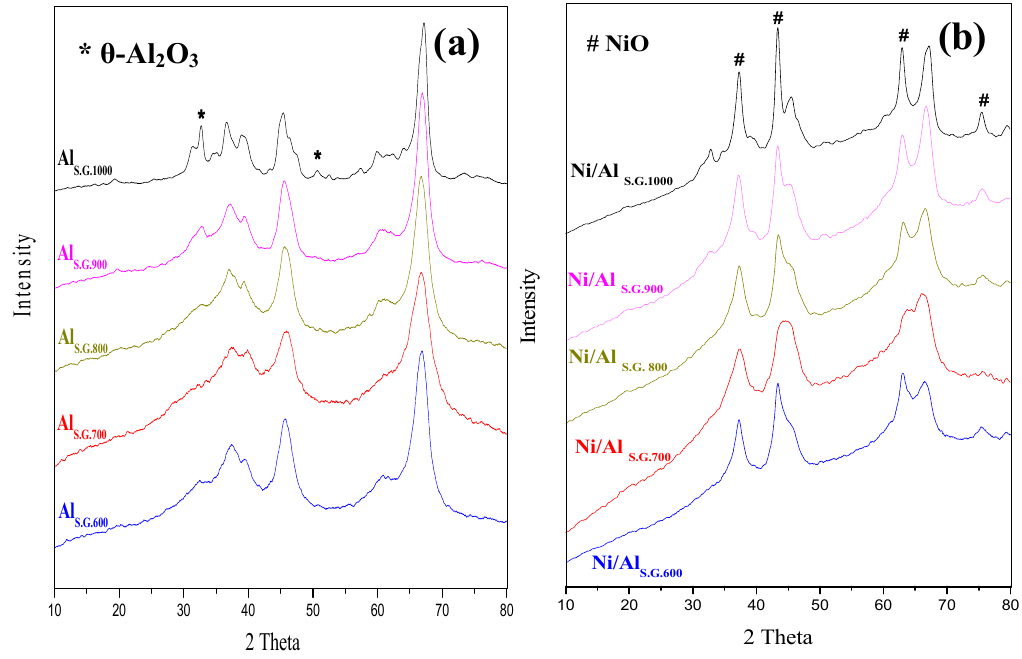
Figure 2. XRD patterns of ( a ) sol gel made alumina supports and ( b ) nickel catalysts supported on sol gel made alumina